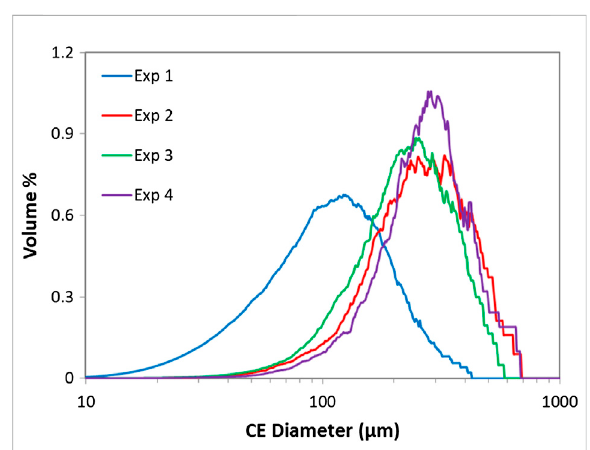
FIGURE 9 Volume weighted circle equivalent diameter distributions from Morphologi G3 for continuous mixer